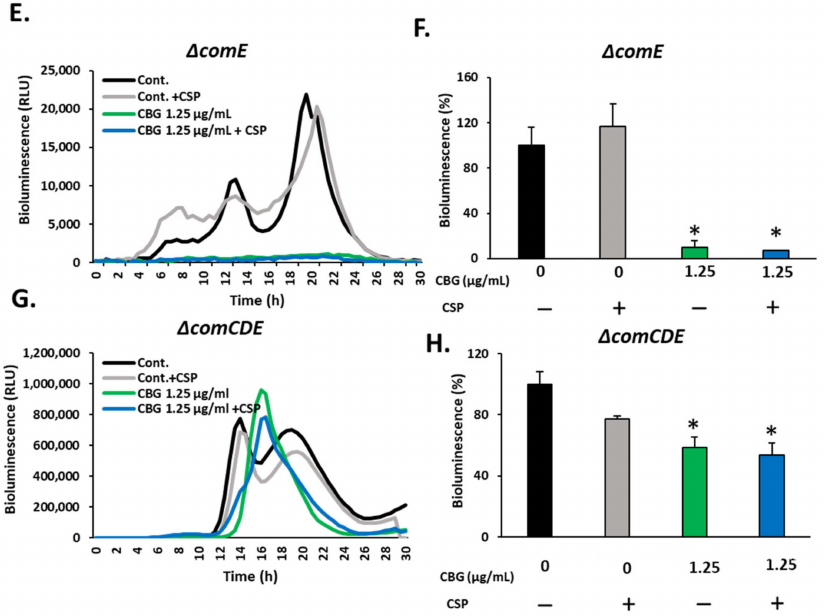
Figure 10. CBG significantly reduced the production of AI-2 by S. mutans . ( A , C , E , G ). The relative bioluminescence induced in the MM77 Vibrio harveyi strain when incubated with 10% of CM collected from the various S. mutans strains that have been exposed to 1.25 µ g/mL CBG and/or 1 µ g/mL 21-CSP for 4 h. The bioluminescence was normalized for differences in bacterial growth by concomi- tantly measuring the optical density at 595 nm. n = 3; * p < 0.05. ( A ). WT; ( C ). ∆ comC ; ( E ). ∆ comE ; ( G ). ∆ comCDE . n = 3. ( B , D , F , H ). The relative bioluminescence as determined by the area under